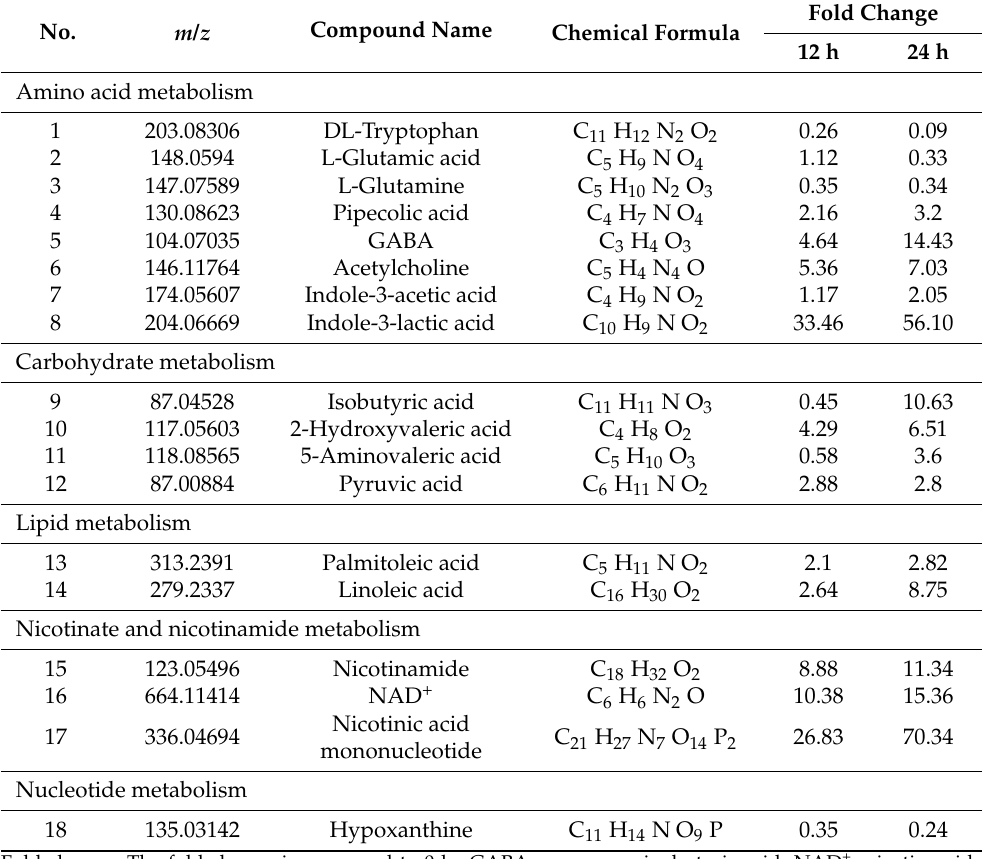
Table 1. The significantly changed metabolites during in vitro fermentation of